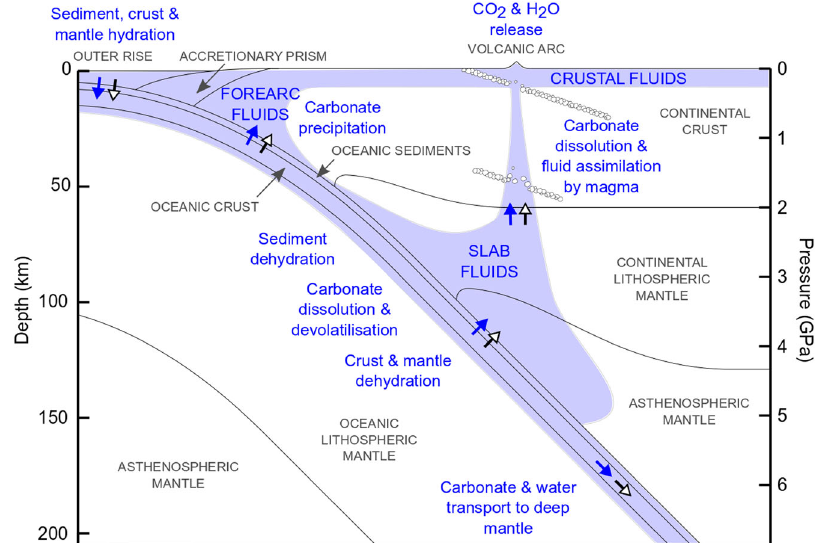
Fig. 1 Fluid – carbonate mineral interactions in the deep carbon cycle. White headed black arrows indicate carbonate fl ux and blue arrows water fl ux. Blue shaded areas indicate water-rich regions. The melting of carbonated igneous oceanic crust is not shown as it starts at depths of 300 km 22 . The image is to scale, apart from the thickness of oceanic sediments that has been